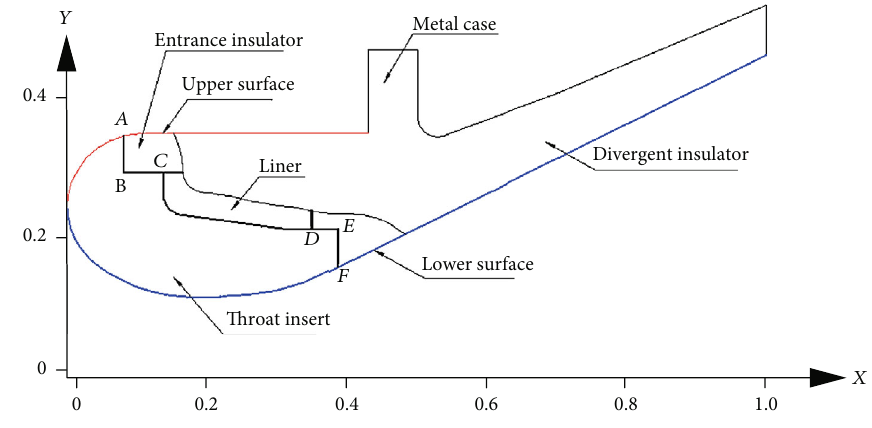
Figure 1: Model of submerged nozzle.